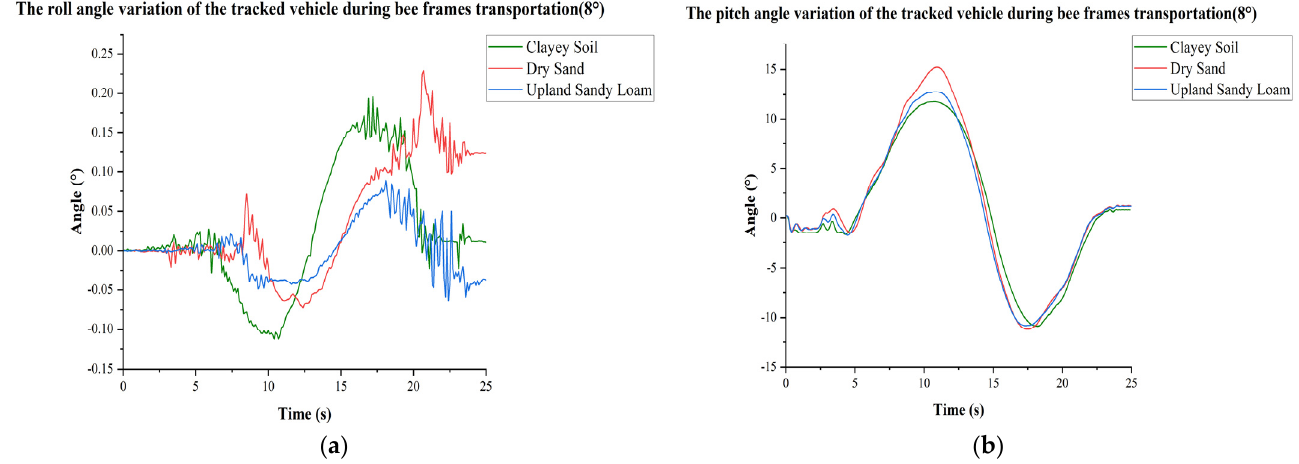
Figure 19. Variation of ( a ) roll values under each pavement condition when the bee frames are fully loaded (8°) and ( b ) pitch values for each pavement condition when the bee frames are fully loaded (8°).